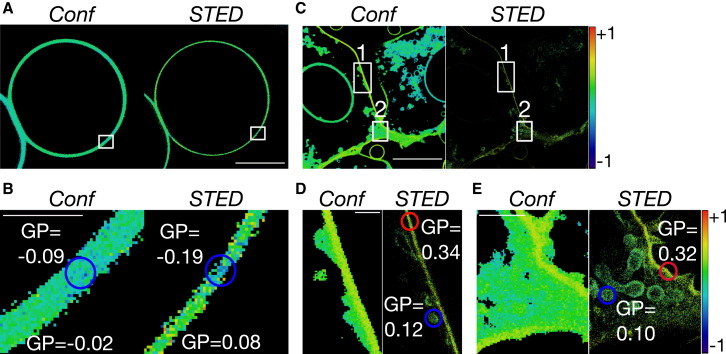
STED GP imaging of membrane nanostructures. (A and B) Given here are confocal and STED GP images of the equatorial planes of a CHO-derived GPMV prepared with 5 mM DTT and labeled with Di-4-AN(F)EPPTEA: (A) overviews (scale bars, 10 μm) and (B) closeups into the white squares (scale bars, 0.5 μm), highlighting the improved GP determination of a nanodomain of low molecular order (blue circle) in the STED mode (GP = −0.19 ± 0.05 (average ± SD) and −0.09 ± 0.07 for the domain compared to GP = 0.08 ± 0.03 and −0.02 ± 0.05 for the surrounding membrane environment in the STED and confocal modes, respectively). (C–E) Given are the confocal and STED GP images of the plasma membrane of live CHO cells labeled with Di-4-AN(F)EPPTEA: (C) overviews (scale bars, 10 μm) and (D and E) closeups into the marked areas (rectangle 1 (D) and rectangle 2 (E); scale bars, 0.5 μm), highlighting the improved GP determination of internal vesicles of low molecular order (blue circles) in the STED recordings (GP = 0.11 ± 0.09 for the vesicles compared to GP = 0.32 ± 0.07 of the plasma membrane (red circles)). Red-to-blue color code: GP values from maximally ordered (red, +1) to maximally disordered (blue, −1). To see this figure in color, go online.